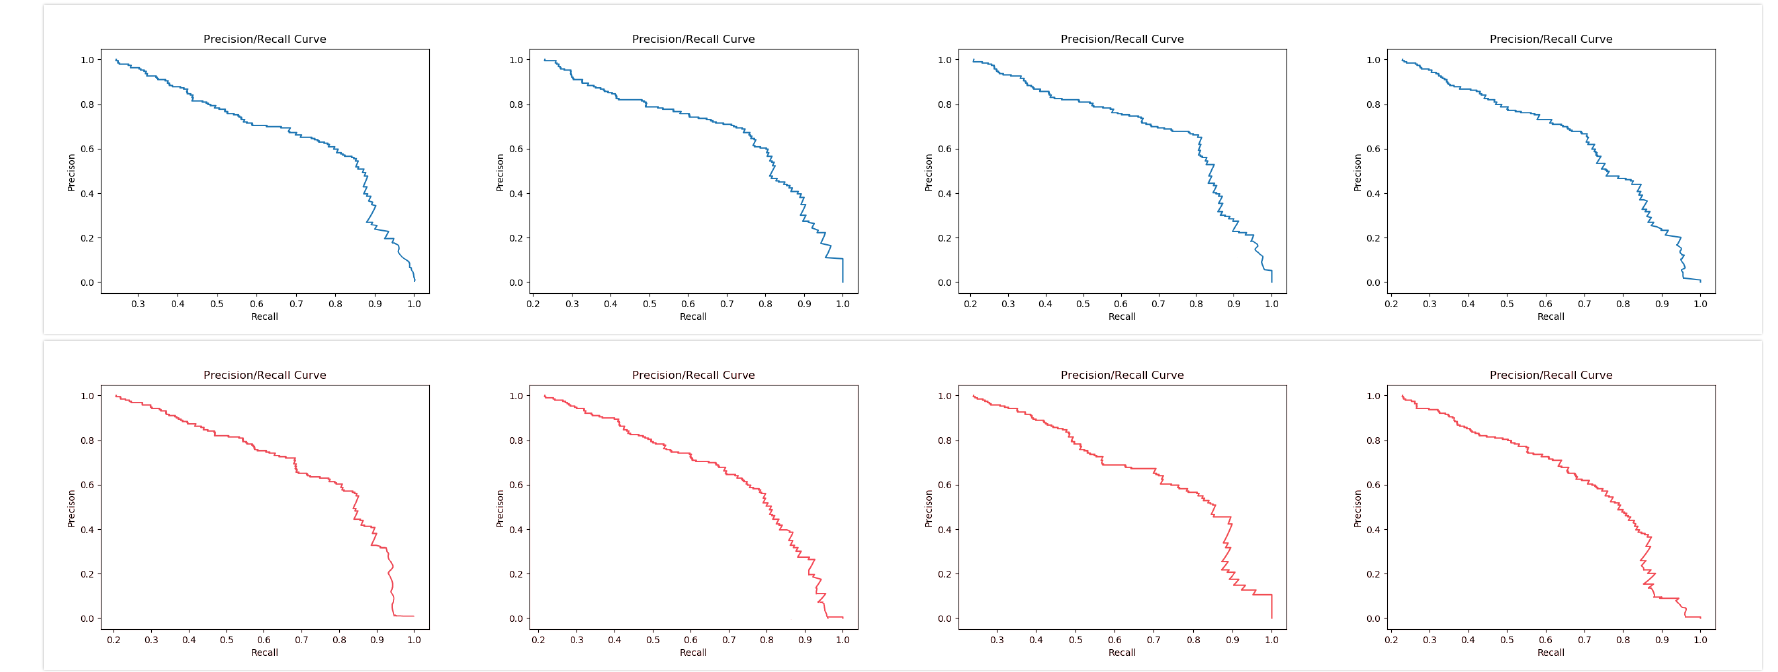
Figure 16. Precision/Recall Curve (blue is BGRU (bidirectional gated recurrent unit), and red for BLSTM (bidirectional long short-term